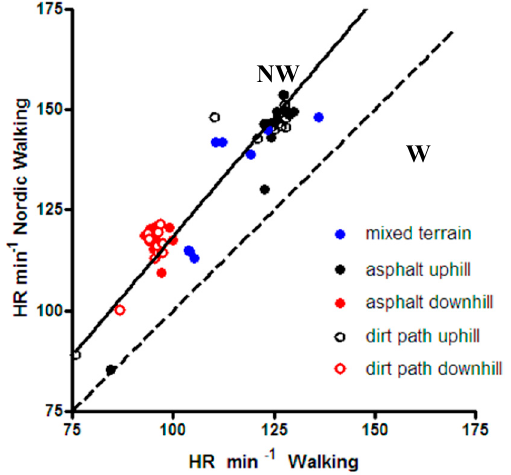
Figure 3. Average heart rates of all subjects recorded during NW (continuous line) and W (dashed line) sessions in each path segment. As expected, heart rate (HR) was higher when hiking uphill than downhill, but in both cases it was higher in NW than in W. The slope of the regression line (continuous line) of the values recorded in NW vs. the values recorded in W had a value of 1.184 ± 0.007, significantly greater than 1 (dashed line), p < 0.001.